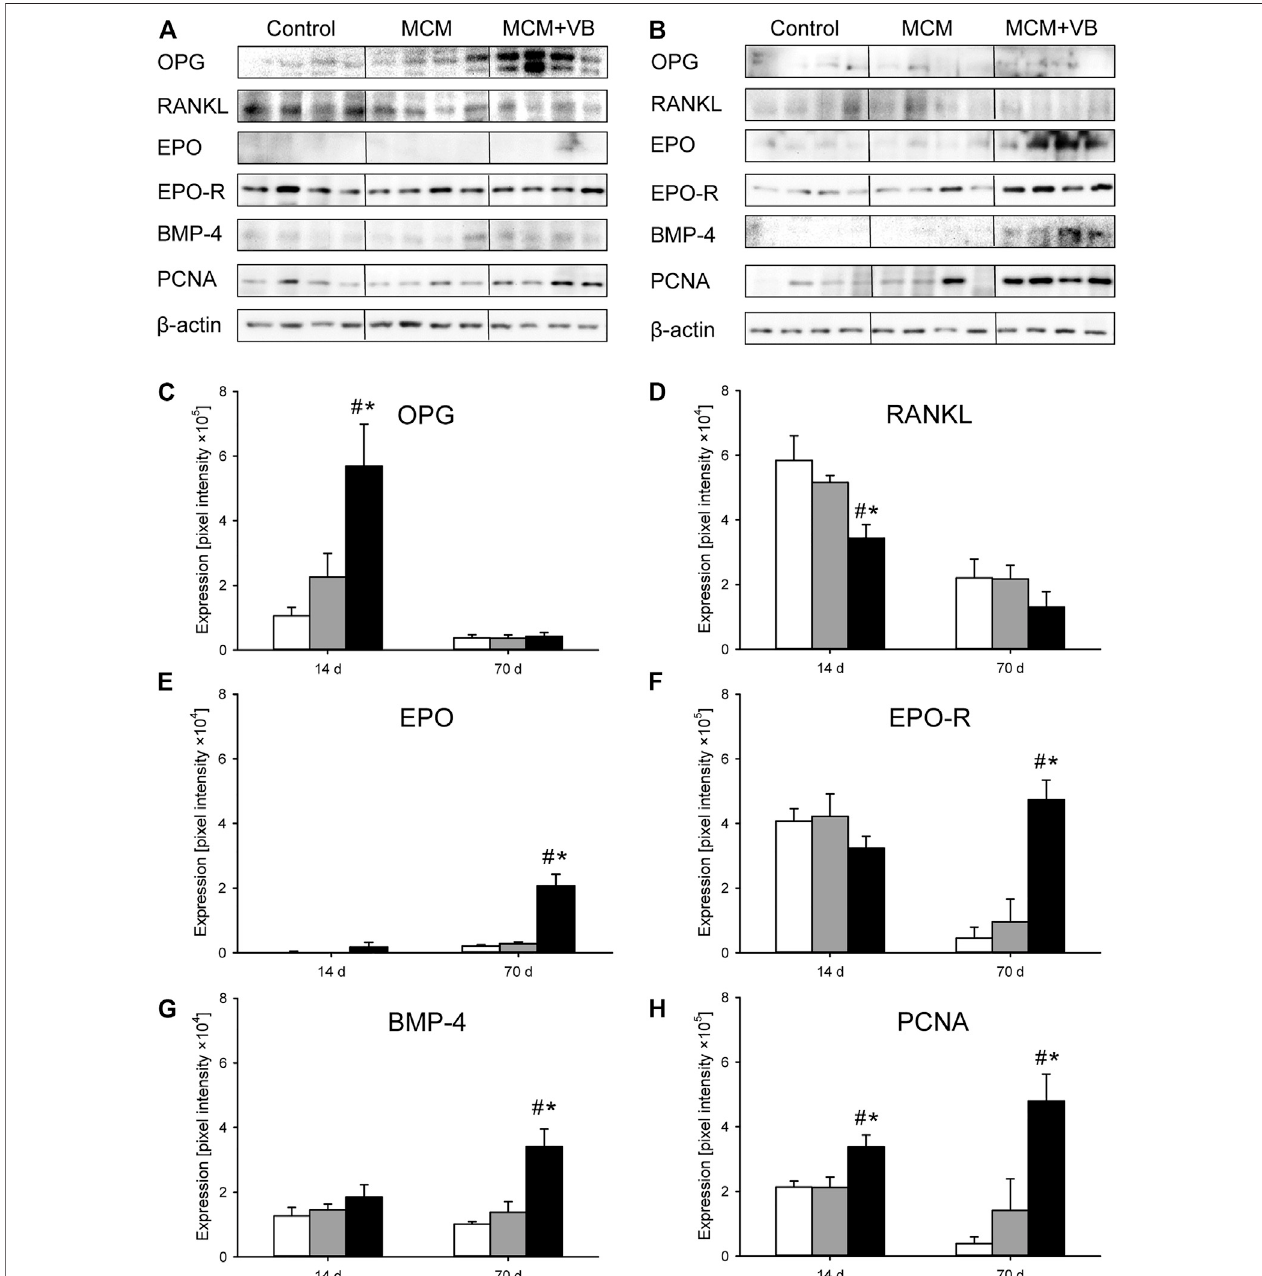
FIGURE7| Western blotanalysisofcallus tissue. A, B: RepresentativeWestern blots ofOPG,RANKL, EPO, EPO-R, BMP-4,PCNA and β -actin expression within thecallus tissue ofcontrol, MCMand MCM+VBfemursat 14 days (A) and70 days (B) afterosteotomy. C-H: ExpressionofOPG (C) , RANKL (D) ,EPO (E) ,EPO-R (F) , BMP-4 (G) and PCNA (H) within the callus tissue of control (white; n (cid:1) 4), MCM (gray; n (cid:1) 4) and MCM + VB (black; n (cid:1) 4) femurs at 14 and 70 days after osteotomy. Mean ± SEM; # p < 0.05 vs control; * p < 0.05 vs MCM.